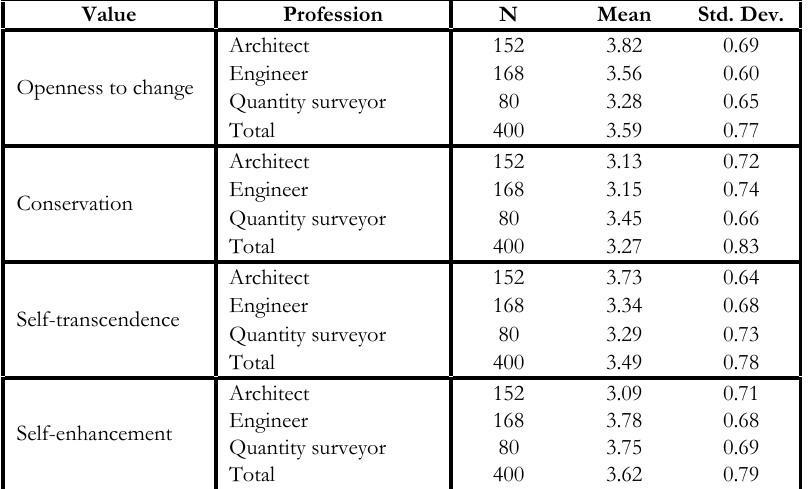
Table 5: Descriptive statistics of the 4 higher-order value types Value Profession N Mean Std. Dev. Architect 152 Engineer 168 Openness to change Quantity surveyor